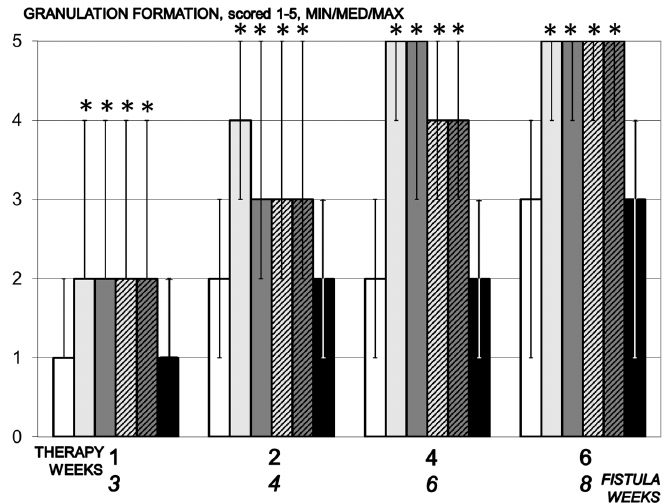
Figure 11. Granulation formation, scored 1–5, min/med/max, time line. Therapy regimens starting at the day 14 after fistula creation (therapy day 0), included BPC 157 given once daily intraperitoneally, last application at 24 h before sacrifice, 10 µg/kg (light gray bars) or 10 ng/kg (dark gray bars) or given perorally, in drinking water 10 µg/kg/day (dashed light gray bars) or 10 ng/kg (dashed dark gray bars) until the sacrifice. Controls received simultaneously an equal volume of saline (5 mL/kg) intraperitoneally (white bars) or drinking water (12 mL/rat/day) (black bars). * p < 0.05, relative to control.